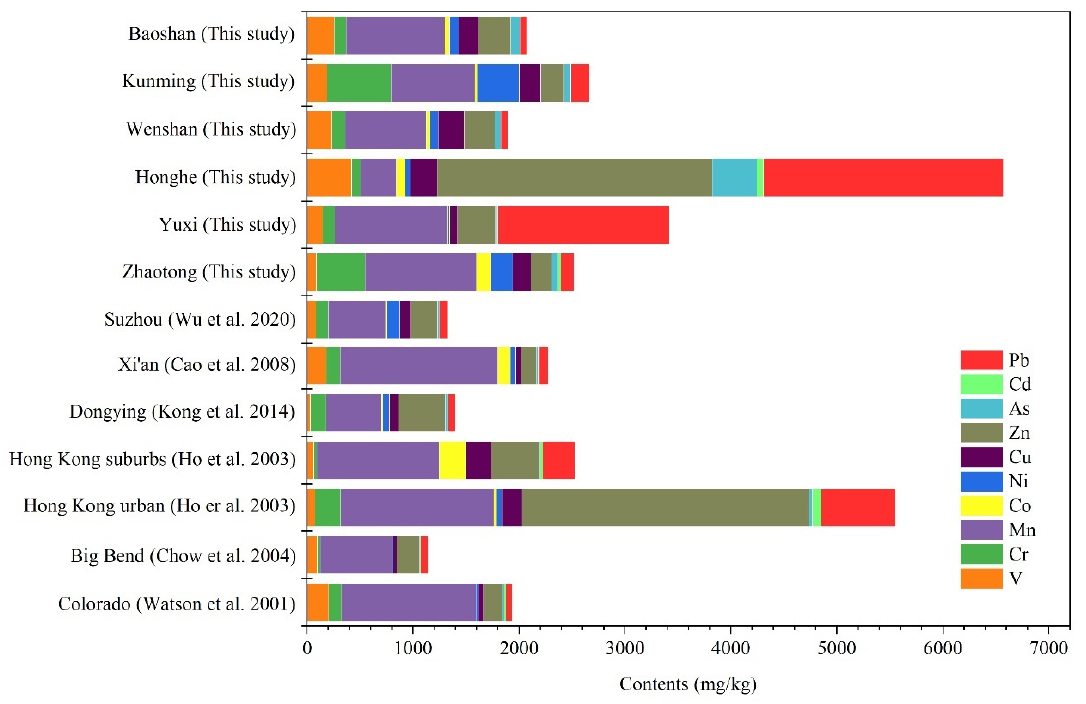
Figure 2. Comparison of the contents of potentially toxic elements in PM 2.5 of soil fugitive dust in different cities.